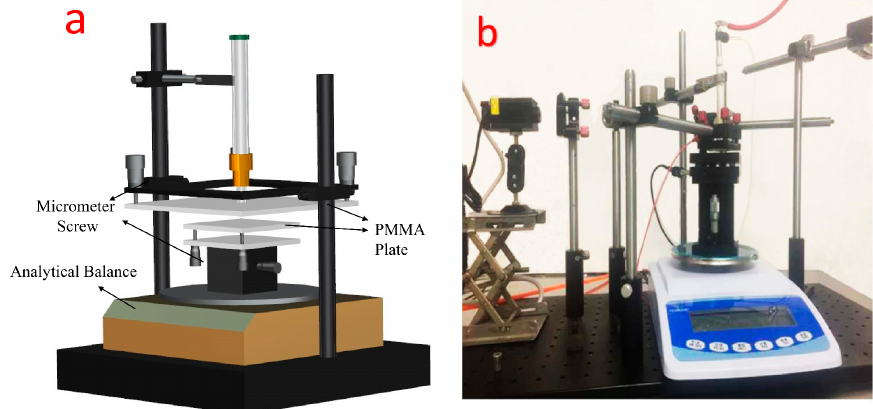
Figure 2. ( a ) The schematic of leveling device for the maskless parallel etching process. Optical apparatus was not shown in this schematic; ( b ) the separated type atmospheric pressure plasma microjets array system.